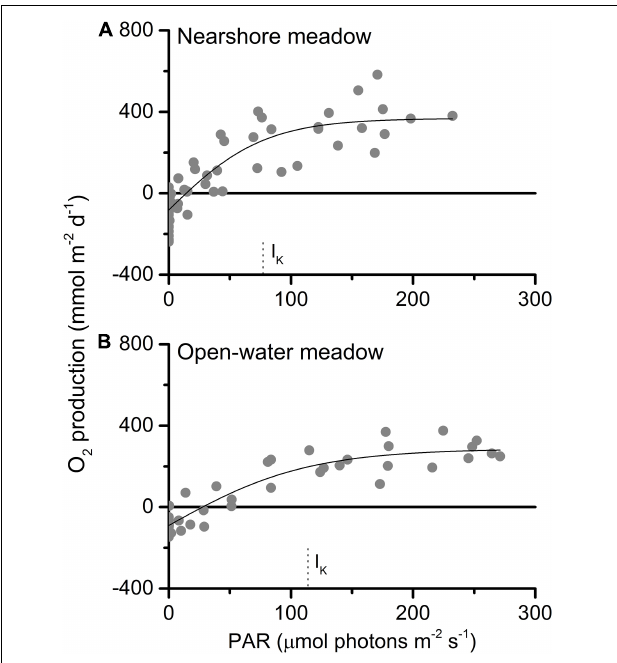
FIGURE 5 | Oxygen production as a function of PAR at (A) nearshore and (B) open-water seagrass meadows. The photosynthetic maxima ( P max ) were 449 ± 36 and 375 ± 27 mmol m − 2 d − 1 ; the light compensation points ( I C ) were 15 and 28 µ mol photons m − 2 s − 1 ; and the saturation irradiances ( I K ) were 77 ± 15 and 113 ± 21 µ mol photons m − 2 s − 1 .